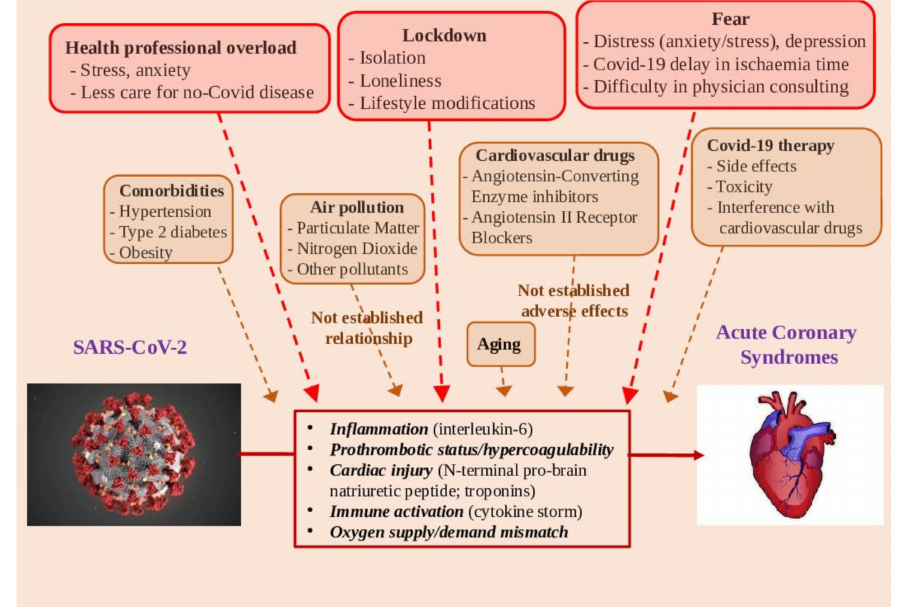
Figure 2. Potential determinants in the relationships between SARS-CoV-2 infection and acute myocardial